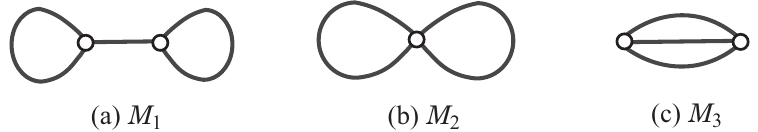
Figure 1. An illustration of the three rank-2 polymer topologies M 1 , M 2 , M 3 ∈ PT ( 2,4 ) .